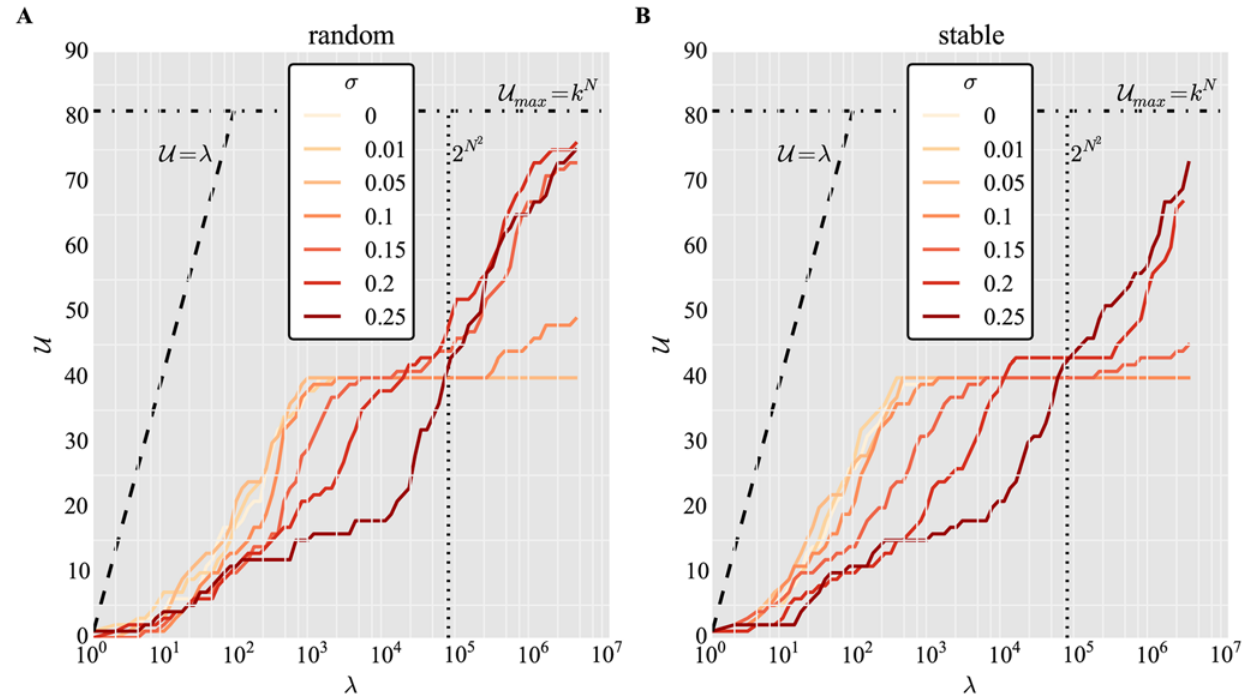
Fig 3. Noise can increase the number of phenotypes accessible by binary networks in high sampling regimes. Number of unique phenotypes U accessed for different sampling sizes λ and varying degrees of noise σ , for (A) random networks and (B) networks pre-selected for stability. Networks are binary, W b , network size N = 4, number of gene expression states k = 3, s off = 0, maximum of T = 100 iterations. Horizontal dashed lines represent the size of phenotype space, U max = k N = 81. Vertical dashed lines represent the size of genotype space, 2 N 2 = 65536. Diagonal dashed lines represent discovery rate without redundancy and overlap, where every new sample yields a new phenotype, i. e. U = λ